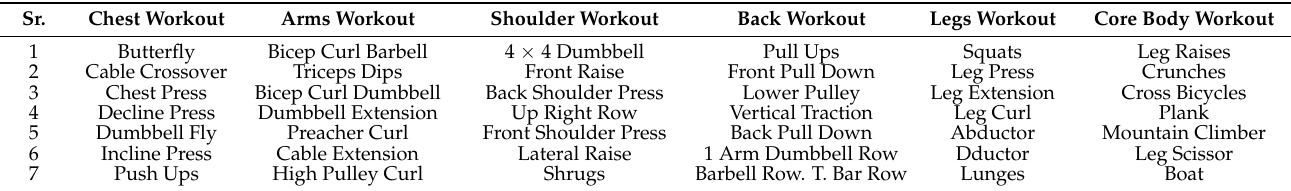
Table 1. Weekly workout routine targeting each muscle group.